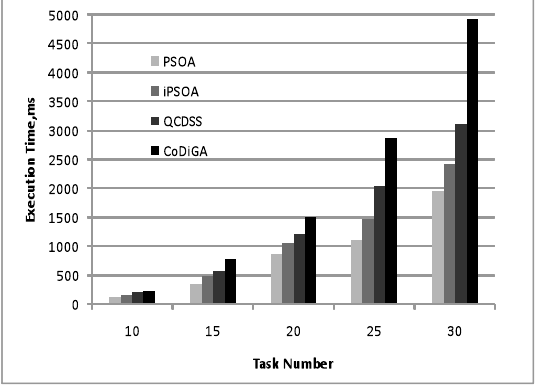
Fig. 10. Comparison of execution